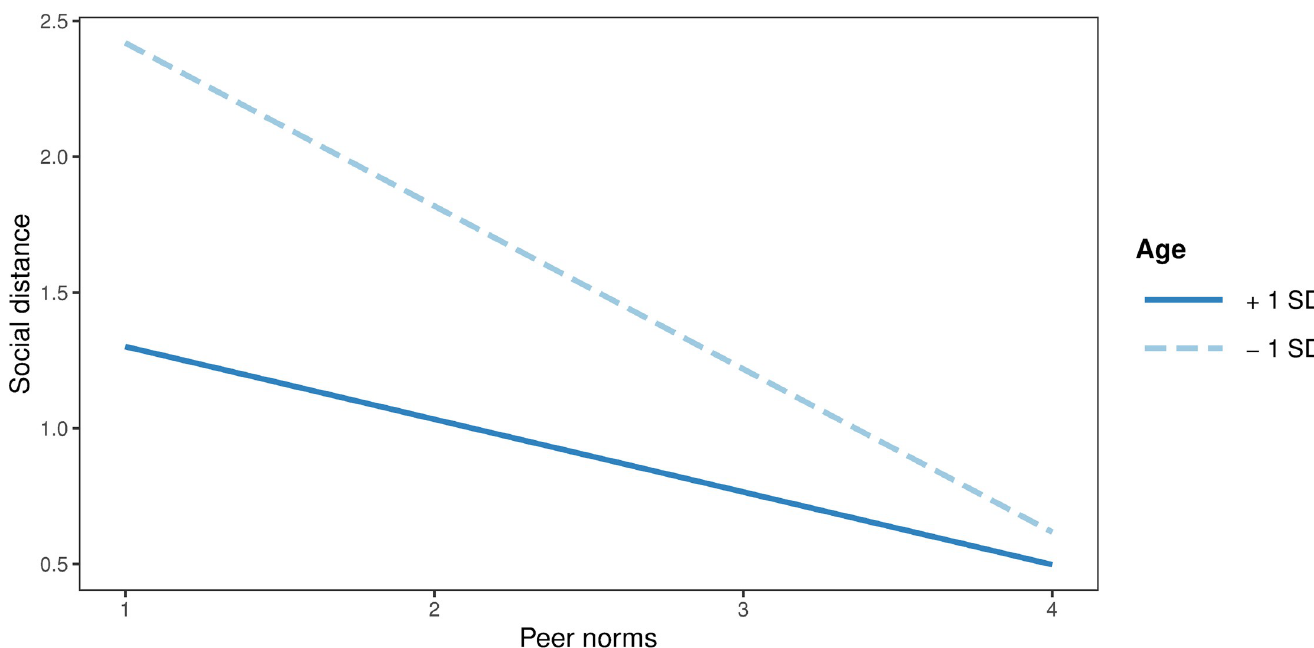
Fig 2. Interaction plot between peer norms and age on social distance. https://doi.org/10.1371/journal.pone.0227512.g002 normative paths were allowed to vary across groups provided good overall fit and did not have a significantly different fit compared with unconstrained model ( Δχ 2 (8) = 12.375, p = .135). Fit indices for the unconstrained, partially constrained and constrained model are reported in Table 4. In this final model, peer ( b = -0.44, SE = 0.12, p < .001) and parental ( b = -0.70, SE = 0.11, p < .001) norms had equal negative effects on in-group bias among both majority and minor- ity participants, while the effect of school norms was not significant ( b = -0.24, SE = 0.15, p = .119). The same negative effects of peer ( b = -0.28, SE = 0.08, p < .001) and parental norms ( b = -0.28, SE = 0.07, p < .001) on discrimination tendencies were found across subgroups, while the effect of school norms was not significant ( b = -0.14, SE = 0.09, p = 0.108). Parental ( b = 0.14, SE = 0.03, p < .001) and school norms ( b = 0.18, SE = 0.03, p < .001) were to the same extent positively related to prosocial behaviour in both subgroups. However, peer norms had a significant positive effect on prosocial behaviour among minority participants ( b = 0.16, SE = 0.04, p < .001) but not among majority participants ( b = 0.06, SE = 0.04, p < .083) Inter- action effect of peer norms and group status on prosocial behaviour in shown graphically in Fig 3. Finally, peer norms had a stronger negative effect on social distance among majority ( b = -0.55, SE = 0.11, p < .001) than among minority participants ( b = -0.29, SE = 0.08, p < .001). Interaction effect of peer norms and group status on social distance in shown graphically in Fig 4. Table 4. Summary of fit statistics for the hypothesised multiple-group path model for group status.